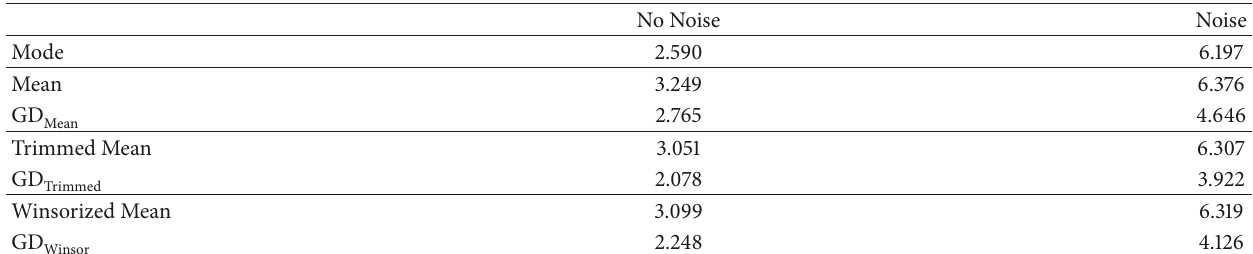
Table 78: Log-normal distributions with step noise (Type 2). The uniform noise is applied in the range from the minimum value to the maximum value of the distribution. The frequency of the samples increases linearly, going to create a noise-shaped step. The noise is composed of 1000 points.